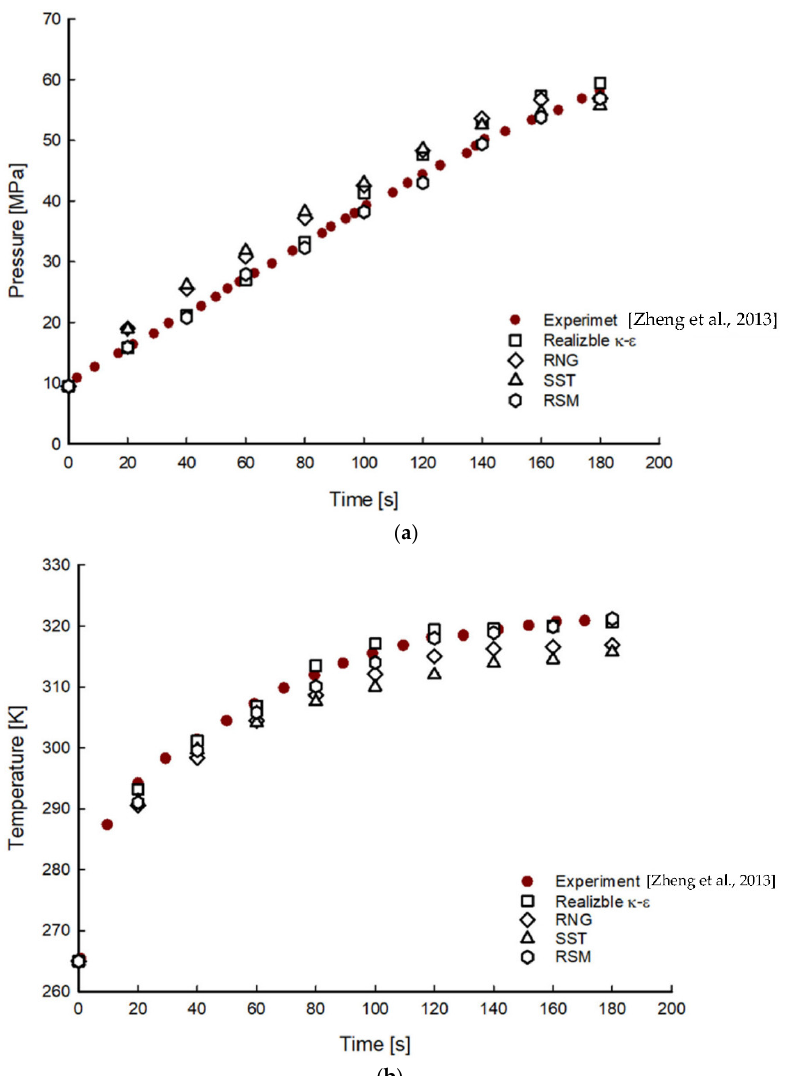
Figure 2. Time histories of pressure ( a ) and temperature ( b ) distributions with different turbulence models during filling processes [6]. Among the different turbulence models, results obtained using the realizable k-epsi- lon and RSM models showed the closest agreement with the experimental values, while those from the RNG and SST models showed the largest deviation. These results are sim- ilar to those reported by Suryan et al. [18].